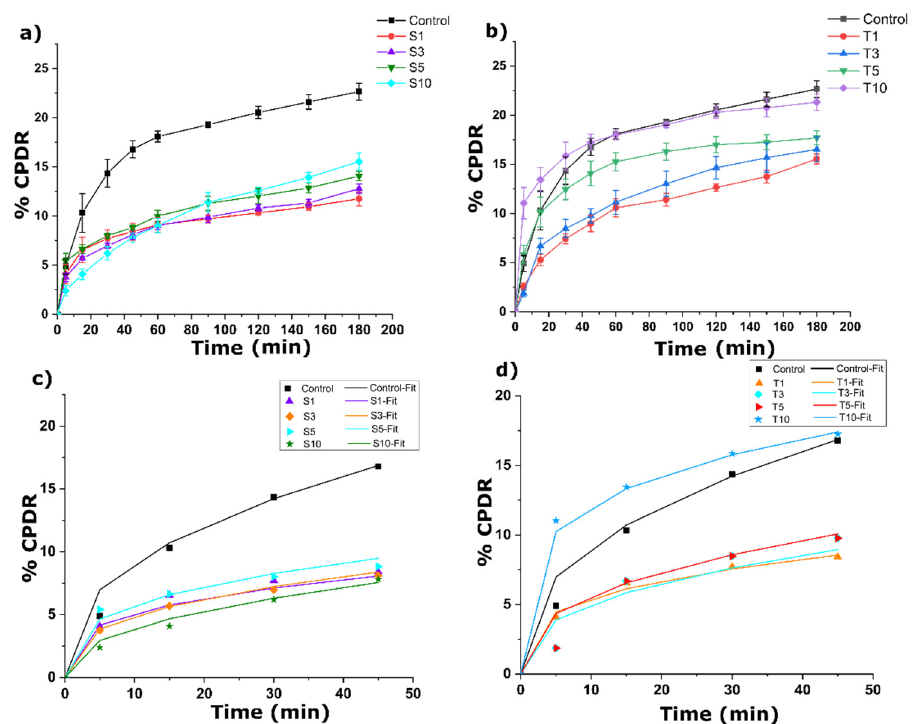
Figure 12. Drug release profile ( a ) SPAN-80 formulations, ( b ) TWEEN-80 formulations ( c ) PS model fitting for SPAN-80 formulation ( d ) PS model fitting for TWEEN-80 formulations. The details of abbreviations used are provided in Section 4.2 (Table 5).